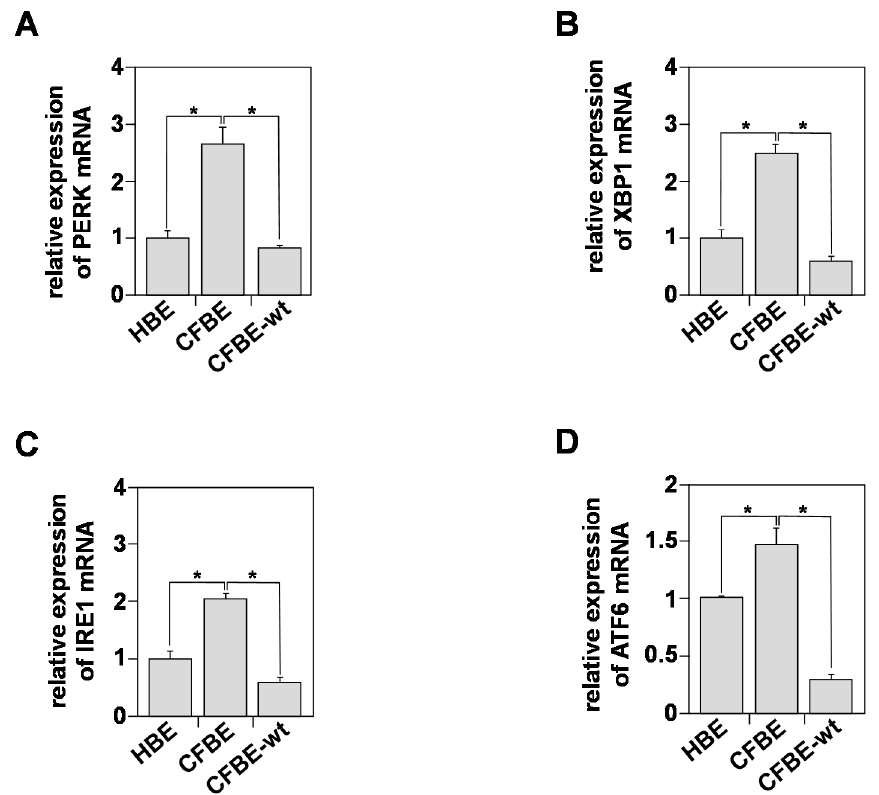
Figure 3. Unfolded Protein Response (UPR) characterization in healthy and CF bronchial cells.